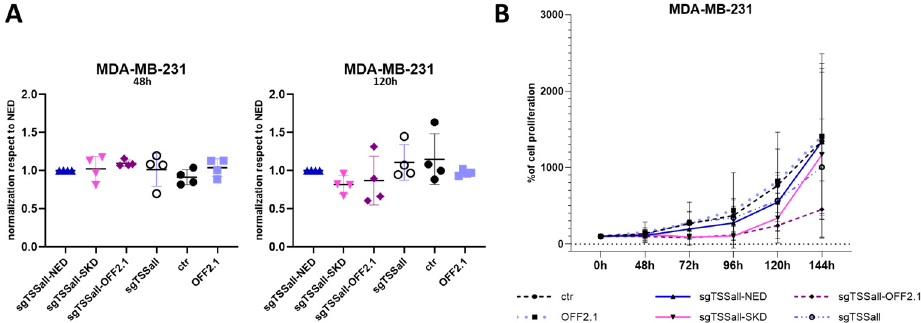
Figure 3. PLAU down-regulation and its functional effect in MDA-MB-231 cells. ( A ) qRT-PCR results of PLAU mRNA expression in MDA-MB-231 cells transfected to transiently express dCas9-SKD or CRISPRoff-v2.1 (OFF2.1) and sgTSSall at 2 (48 h, left panel) and 5 days (120 h) after transfection (right panel), compared to dCas9-NED. As negative controls, cells were transfected to express sgRNA only (sgTSSall) or CRISPRoff-v2.1 (OFF2.1) only. ( B ) Proliferation assay results of the cells transfected with plasmids shown in ( A ). Data are represented as means of 4 independent experiments.